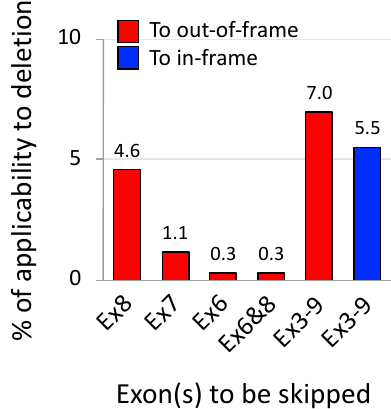
Figure 7. Theoretical applicability of exons 3–9 skipping to patients with out-of- and in-frame deletions. From the Leiden DMD database, 3232 patients with out-of-frame deletions and 1611 with in-frame deletions were extracted and were calculated for the applicability of certain exon skipping strategies to out-of- (red) and in-frame deletions (blue), respectively. Exons 3–9 skipping might become a potential therapy for patients with deletions in the proximal hot spot region that cause more variable severity.